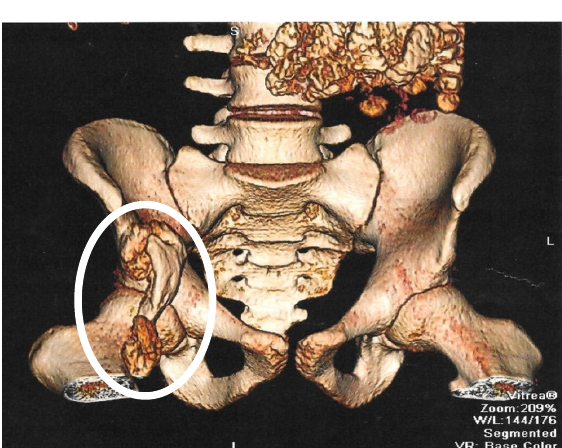
Figure A1. Patient no 1. CT image—A heterogeneous tumor with the aspect of calcified myositis located in the right iliopsoas muscle.